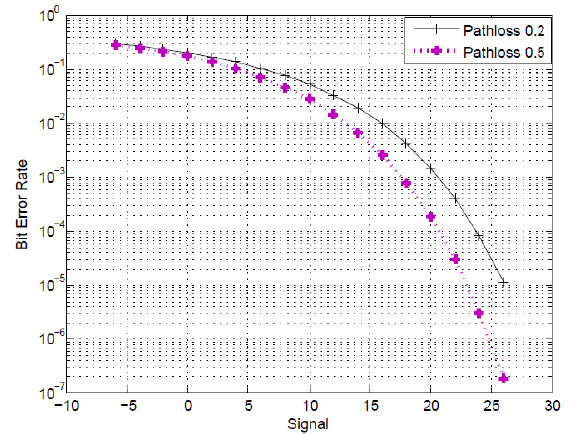
Fig. 5: Relationship between BER against the signal